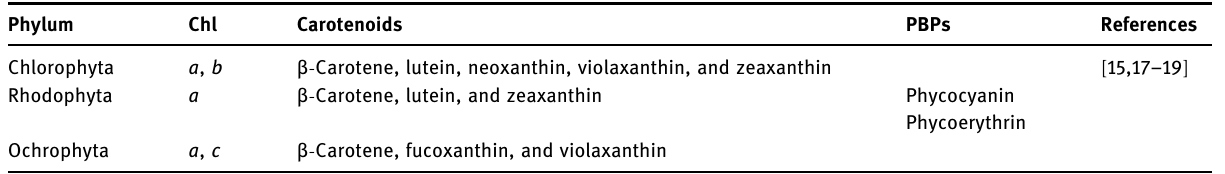
Table 1: Pigment composition in each seaweed phylum Phylum Chl Carotenoids